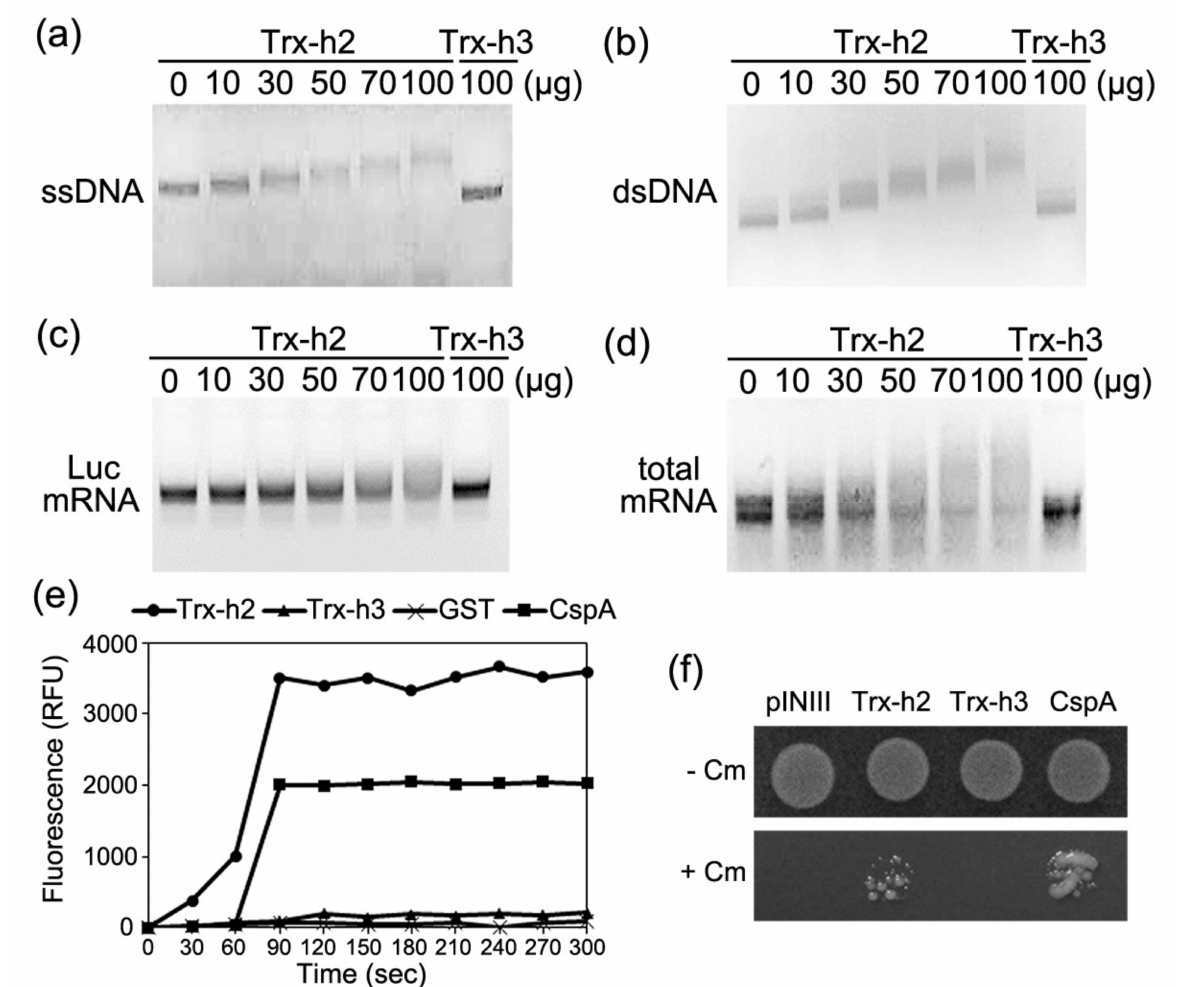
Figure 5. Nucleic acid binding and melting activity of Trx-h2. ( a – d ) electrophoretic mobility shift assay (EMSA) using varying amounts of Trx-h2 incubated with M13mp8 ssDNA ( a ), M13mp8 dsDNA ( b ), luciferase (Luc) mRNA ( c ), or Arabidopsis total RNAs ( d ). A shift in the mobility of the Trx-h2/nucleic acid complexes was analyzed on 0.8% agarose gels. Trx-h3 (100 µ g) was used as a control. ( e ) nucleic acid melting assay using a molecular beacon as a substrate. The molecular beacon was incubated with Trx-h2 (- • -), Trx-h3 (- (cid:78) -), GST (-x-), or CspA (- (cid:4) -), and fluorescence intensity was measured at various time points at excitation and emission wavelengths of 555 and 575 nm, respectively. ( f ) DNA melting activity of Trx-h2 in RL211 E. coli cells in vivo. Anti-termination activity of Trx-h2 in E. coli RL211 cells. Trx-h2 was transformed into RL211 cells, which harbor the chloramphenicol (Cm) resistance gene ( chloramphenicol acetyltransferase [ CAT ]) downstream of the trpL terminator, and was grown for 2 days on LB-agar medium supplemented with (+) or without ( − ) Cm at 37 ◦ C. Cells transformed with the pINIII vector, CspA , and Trx-h3 were used as